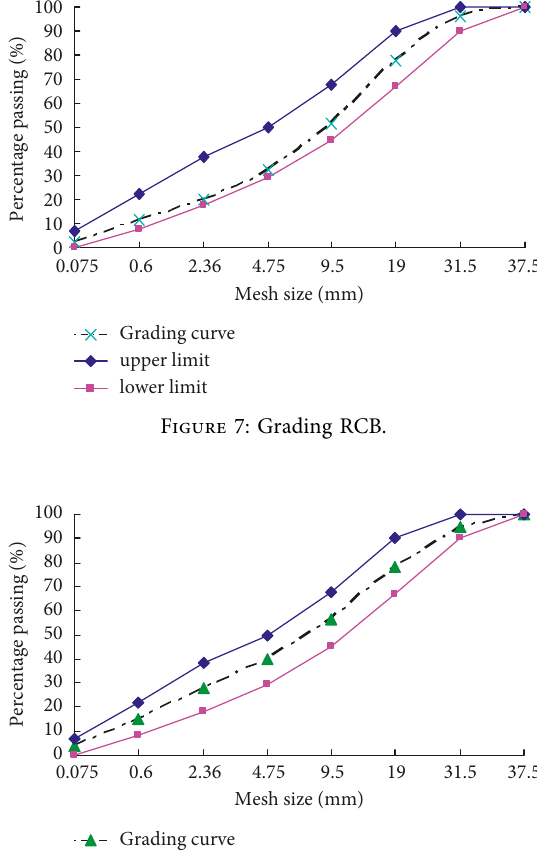
Figure 8: Grading RBA.